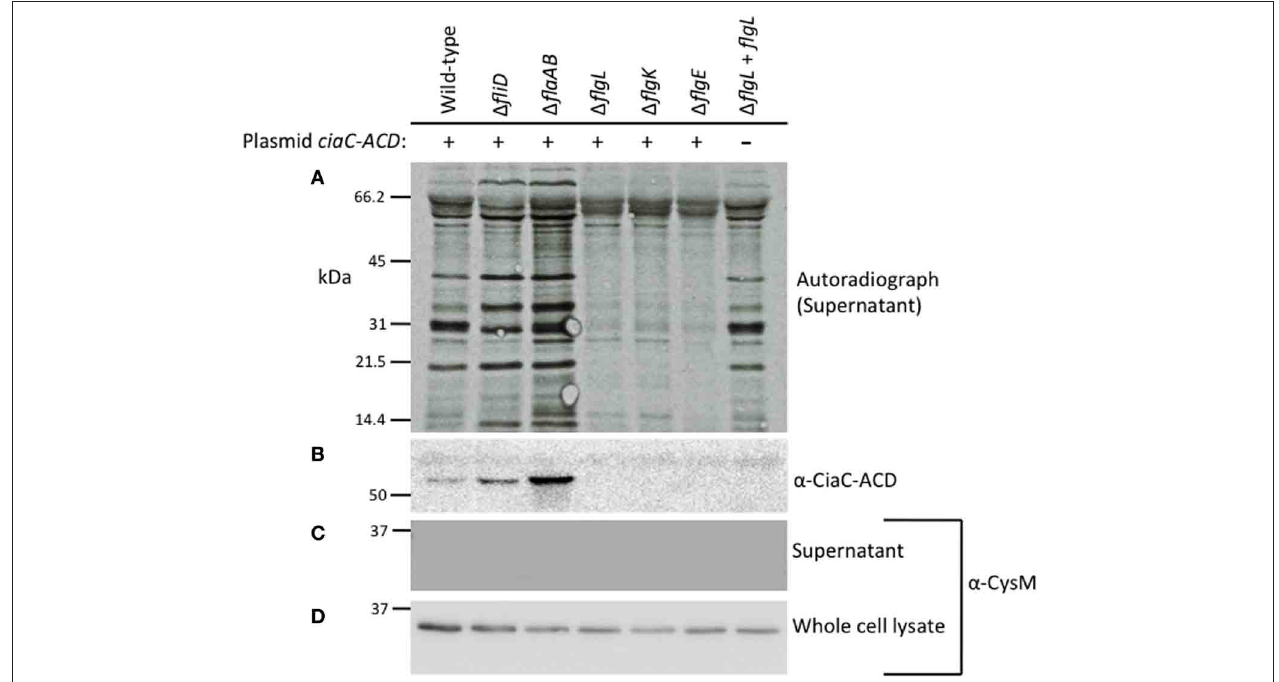
concentrated 10-fold, separated by SDS-PAGE, transferred to PVDF membranes, and exposed to X-ray film (A) or probed with an anti-ACD antibody (B) . Faint bands present in all lanes represent bovine serum albumin (66.5kDa) and degradation products. The molecular mass of the pre-stained protein standards are listed in kDa. Supernatants (C) and whole-cell lysates (D) were probed with anti-CysM antibody to confirm that cell lysis did not